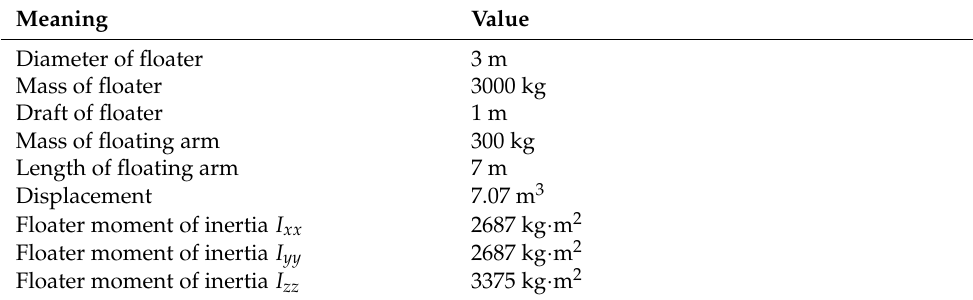
Table 3. Parameters of one floater.